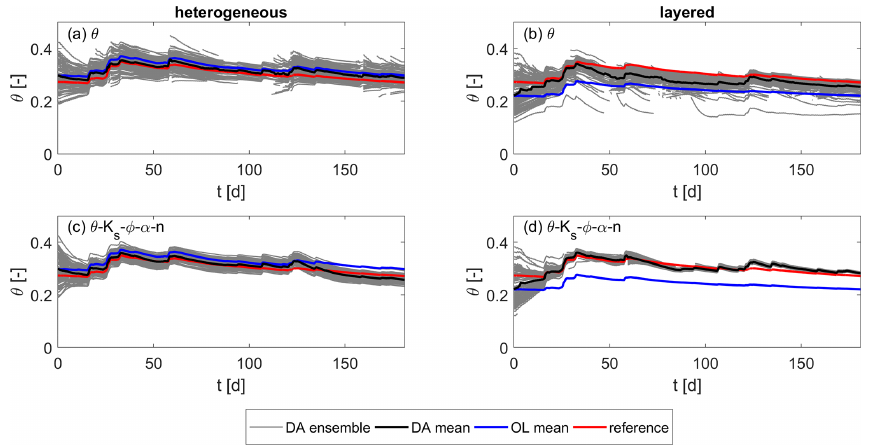
Figure 20. Root zone soil moisture over time for the heterogeneous scenario. (a, c) Results using a heterogeneous structure in the ensemble. (b, d) Results using a simplified layered soil in the ensemble. (a, b) Updates of soil moisture only. (c, d) Joint updates of soil moisture and all